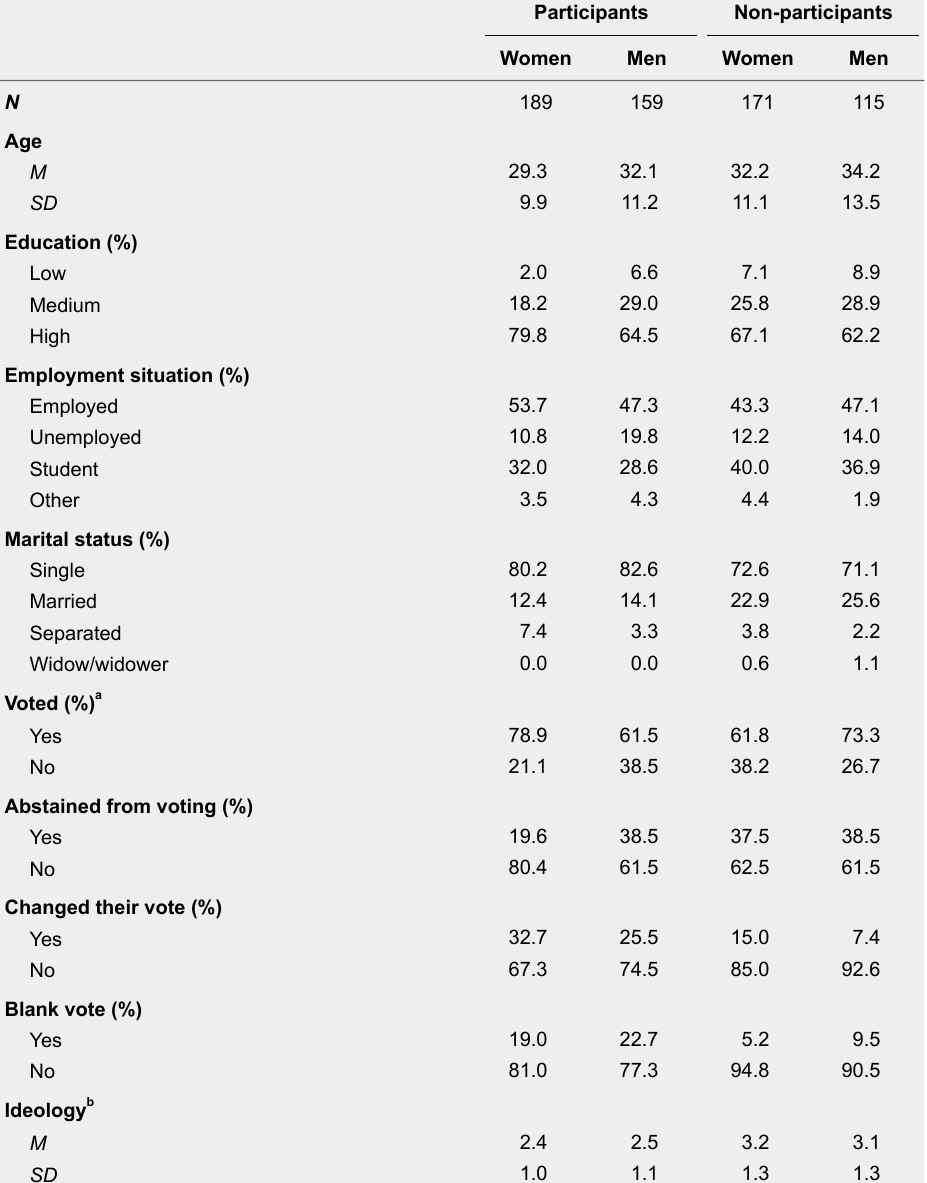
Socio-Demographic Characteristics of 15-M Participants and Non-Participants